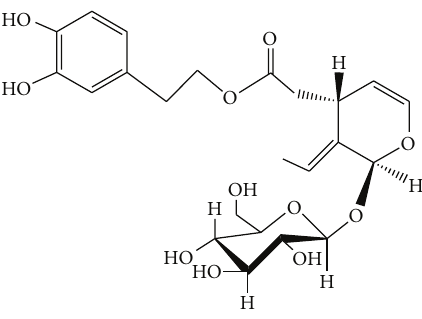
Figure 1: Chemical structure of